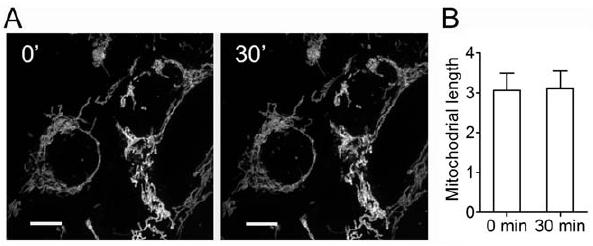
Figure 1. Cell Fixation Does not Alter Mitochondrial Morphol- ogy Probed by Staining with MitoTracker-Red CMXRos. A. Representative images of mitochondria in the same SH-SY5Y cells stained with MitoTracker-Red CMXRos were taken immediately before and 30 min after fixation with 4% paraformaldehyde on live cell imaging system. Mitochondrial morphology in SH-SY5Y cells remains almost the same after fixation for 30 min. Scale bars for 10 m m. B. Quantitative analysis of changes in mitochondrial length of the same SH-SY5Y cells in images taken immediately before and 30 min after fixation. The experiment was carried out five times, and no perceptible difference in mitochondrial length is detected in SH-SY5Y cells after